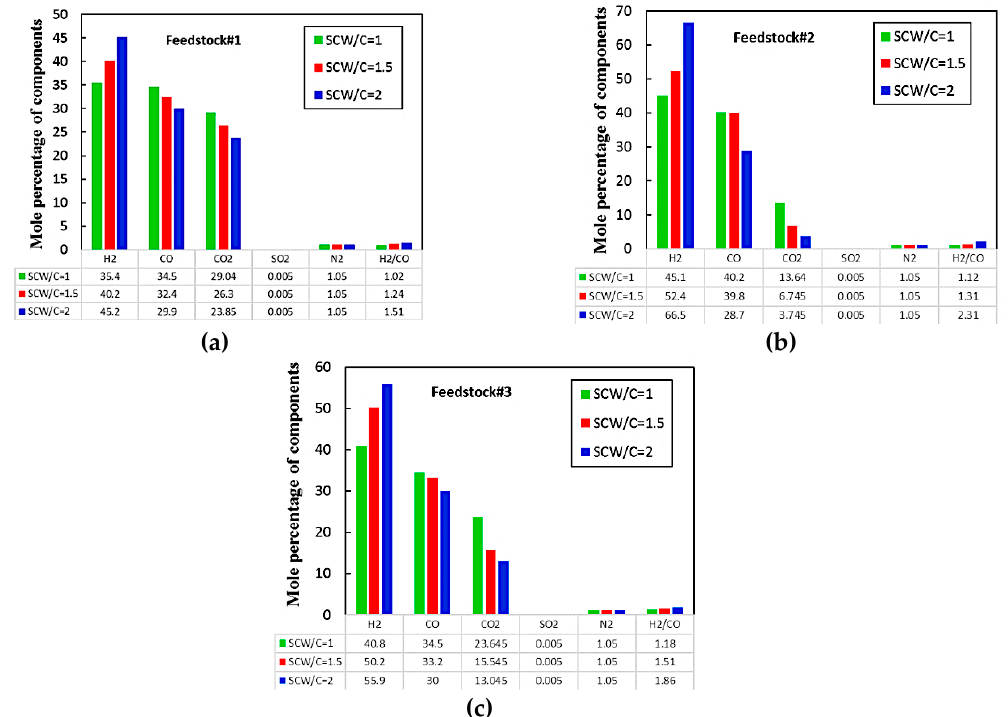
Figure 11. Mole percentage of components in gaseous products for different molar ratios of SCW/C and for different biomass feedstock given in Table 2 and at 900 °C ( a ) feedstock #1, ( b ) feedstock #2, and ( c ) feedstock #3.